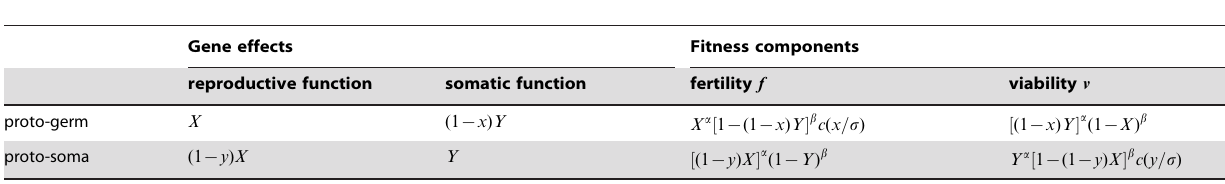
Table 1. Gene effects on reproductive and somatic function as well as fertility and viability of the proto-germ and proto-soma cells in the general